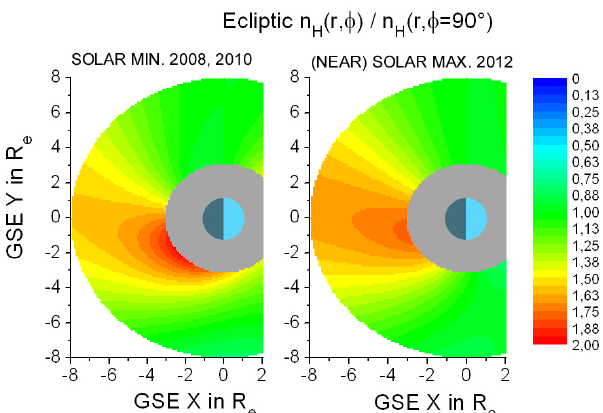
Figure 14. Dawn/dusk asymmetry plotted as the H-column den- sity ratio for the regions between “midnight-dawn” and “midnight- dusk” for the solar minimum (blue) and the solar maximum (red) model fit. Between 8 and 10 R e the plot shows model-extrapolated values, which might have a larger uncertainty compared to 8 R e (light